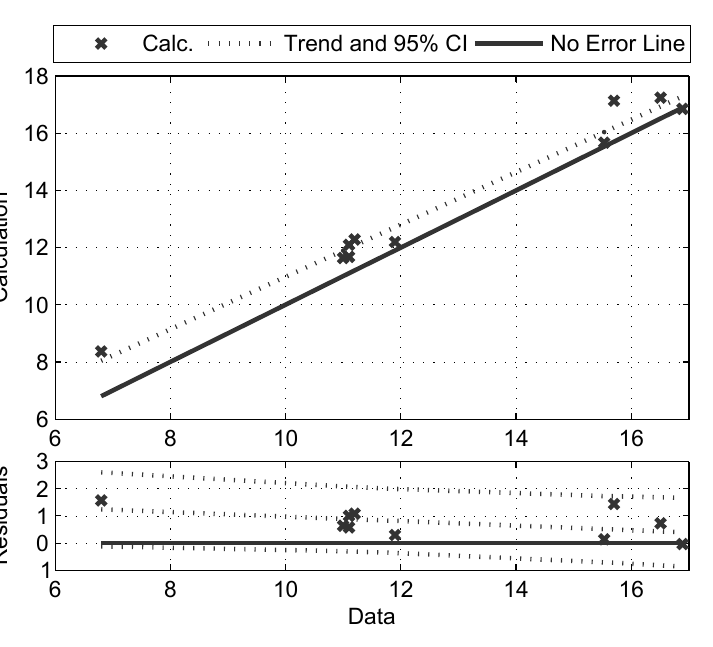
Fig. 14. Calculated impulse compared to data for ten tests (MPa · ms)